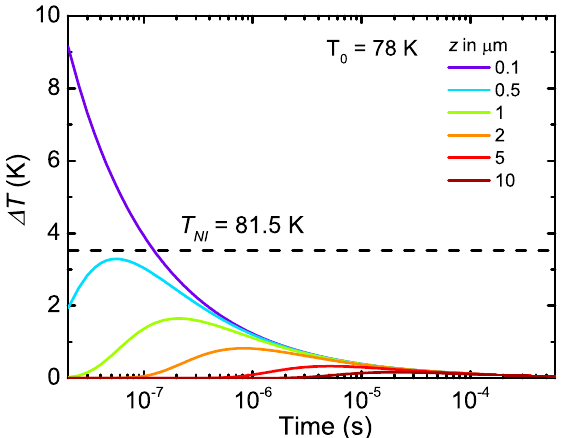
Figure D1. Temporal evolution of the change of sample temperature of TTF-CA for a laser intensity of 0.71 mJ/cm 2 at T 0 = 78 K derived from Equation (D2). Starting from a depth of 500 nm, the maximum of the temperature profile stays clearly below T NI = 81.5